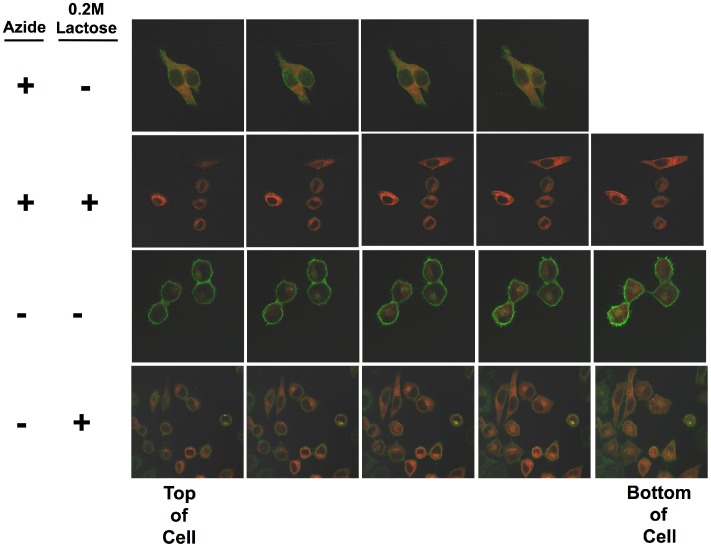
Internalization of ricin/mAb immune complexes.Experimental conditions are as described in figure 2, except in this case the cells were first incubated with unlabeled ricin, washed, and then with Alexa 488-conjugated RAC18, either in the cold with azide, or at 370 in tissue culture medium.